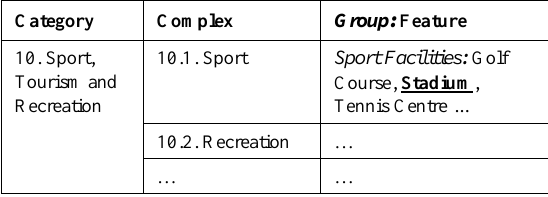
Table 3. Hierarchy for feature ‘stadium’ in the